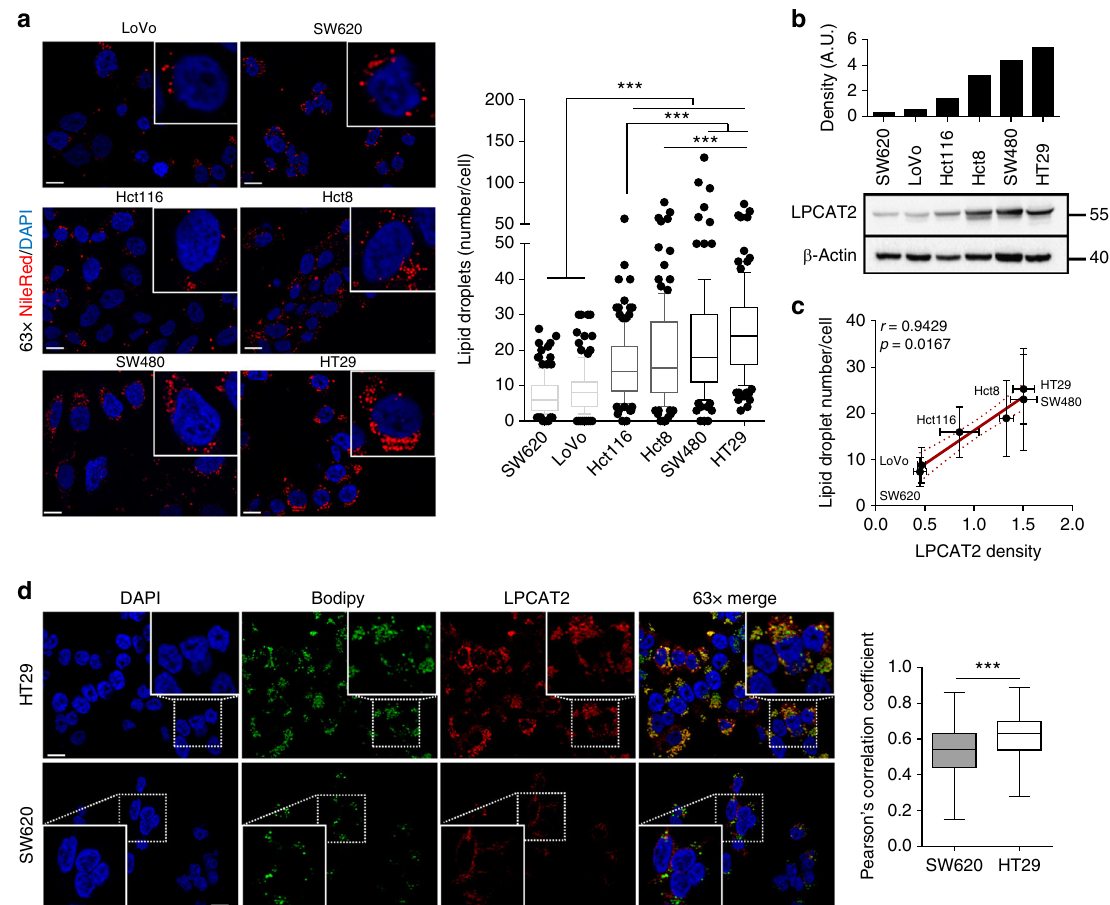
Fig. 1 LD production correlates with LPCAT2 expression in CRC cell lines. a Basal LD content assessed by Nile red staining after 48 h of seeding. Left panel, representative confocal images of Nile red staining (×63 magni fi cation, scale bar = 10 µ m). Nuclei (blue), LD (red). Right panel, LD quanti fi cation was performed by counting red lipid bodies on merged pictures (300 cells per cell line) with Image J software (right). Whiskers denote 1 st and 99 th percentiles. P values were determined by a two-way ANOVA with Bonferroni correction. *** p < 0.001. b LPCAT2 basal expression. A representative blot from three independent experiments is shown. c A signi fi cant Spearman correlation coef fi cient ( p = 0.0167) was found between basal LPCAT2 protein density and LD content from three independent experiments. d SW620 and HT29 cells were stained after 48 h of seeding with Bodipy 493/503 (green) and LPCAT2 antibody (red), and counterstained with DAPI (blue). The Pearson correlation coef fi cient was calculated between LPCAT2 and Bodipy fl